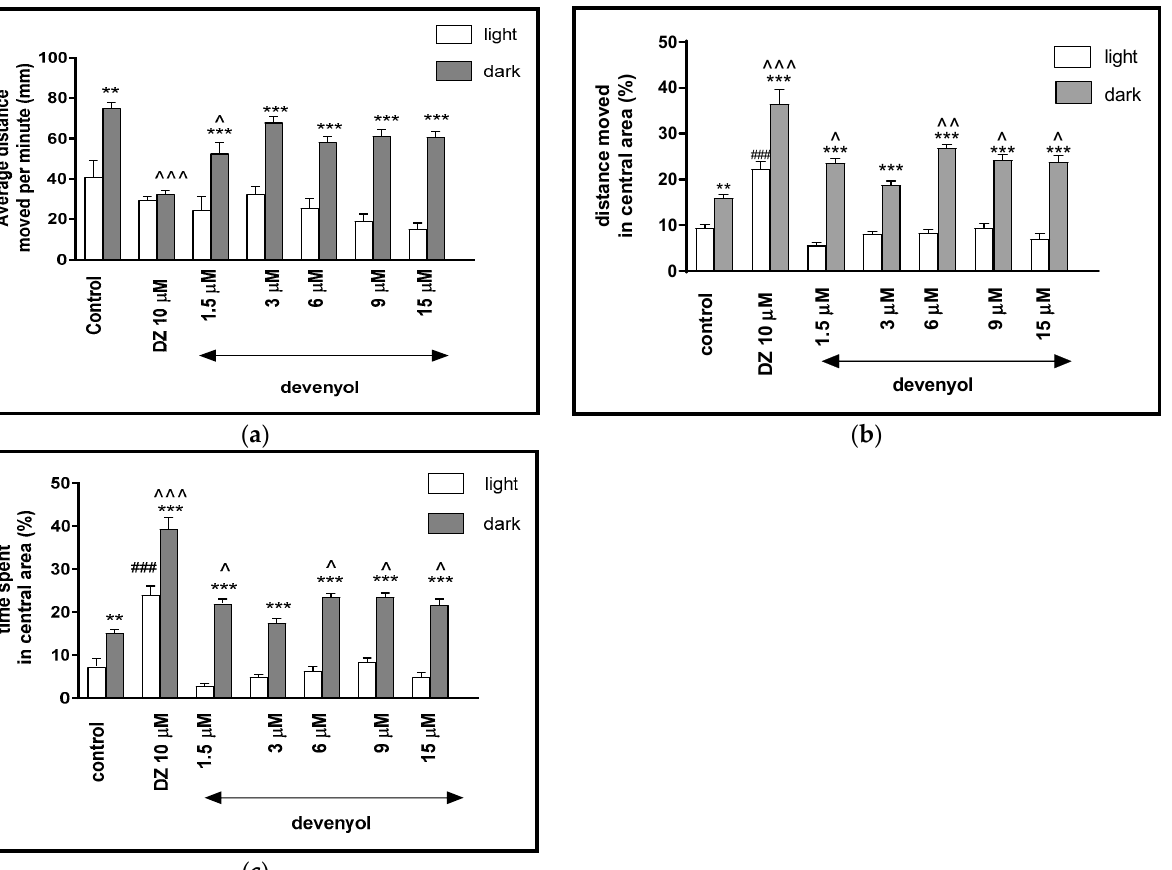
Figure 3. The effects of devenyol (1.5, 3, 6, 9 and 15 µM) and diazepam (DZ, 10 µM) on locomotor activity during all three light–dark challenge phase. ( a ) Average distance moved by zebrafish larvae within each 1-min time bin under either light (open bars) or dark (filled bars). ( b ) The percentage of distance moved by zebrafish larvae in the central area during light phase (white bars) or dark phase (filled bars). ( c ) The percentage of time spent by zebrafish larvae in the central area during light phase (white bars) or dark phase (filled bars). Data are presented as mean ± SEM; n = 32. ** p < 0.01, *** p < 0.001 in comparison to light conditions within the same concentration group; ^ p < 0.05, ^^ p < 0.01, ^^^ p < 0.001 in comparison to control group under dark condition; ### p < 0.001 in comparison to control group under light condition (post hoc Bonferroni’s test).